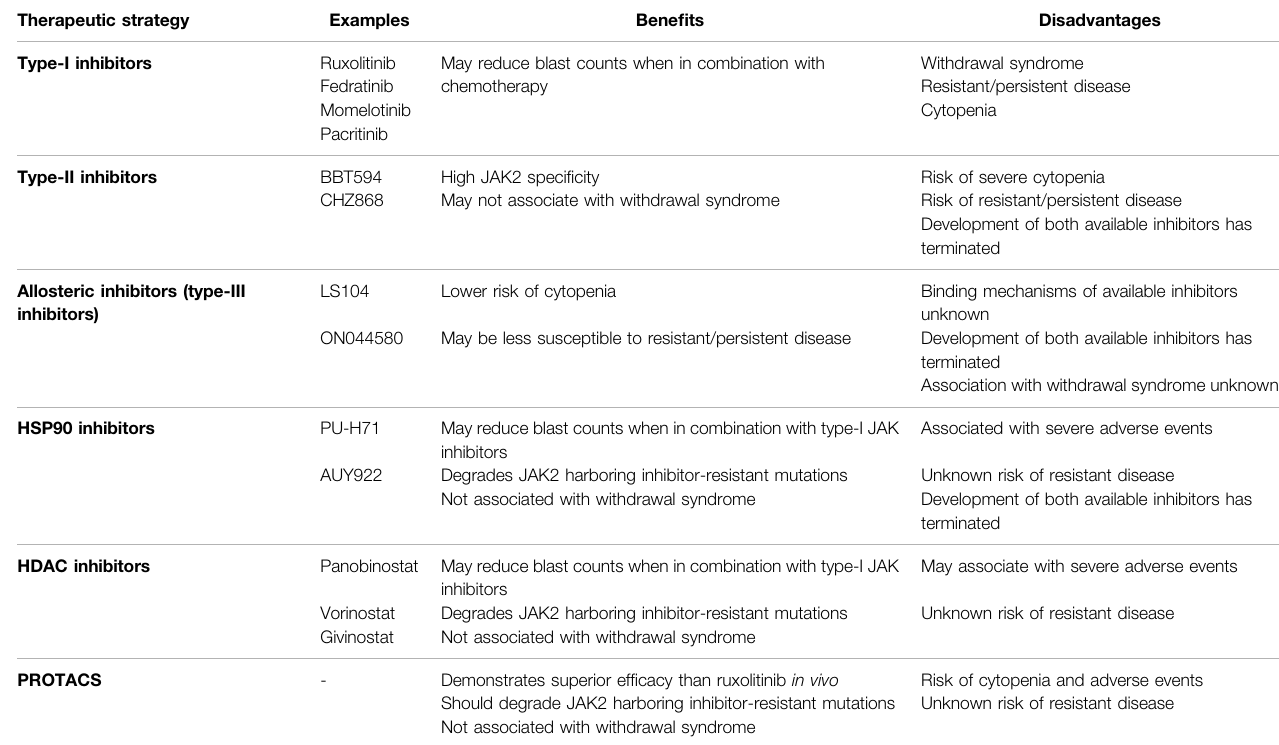
TABLE 5 | Current precision medicine approaches to target JAK2 in JAK2 -altered ALL and their associated bene fi ts and disadvantages. Therapeutic